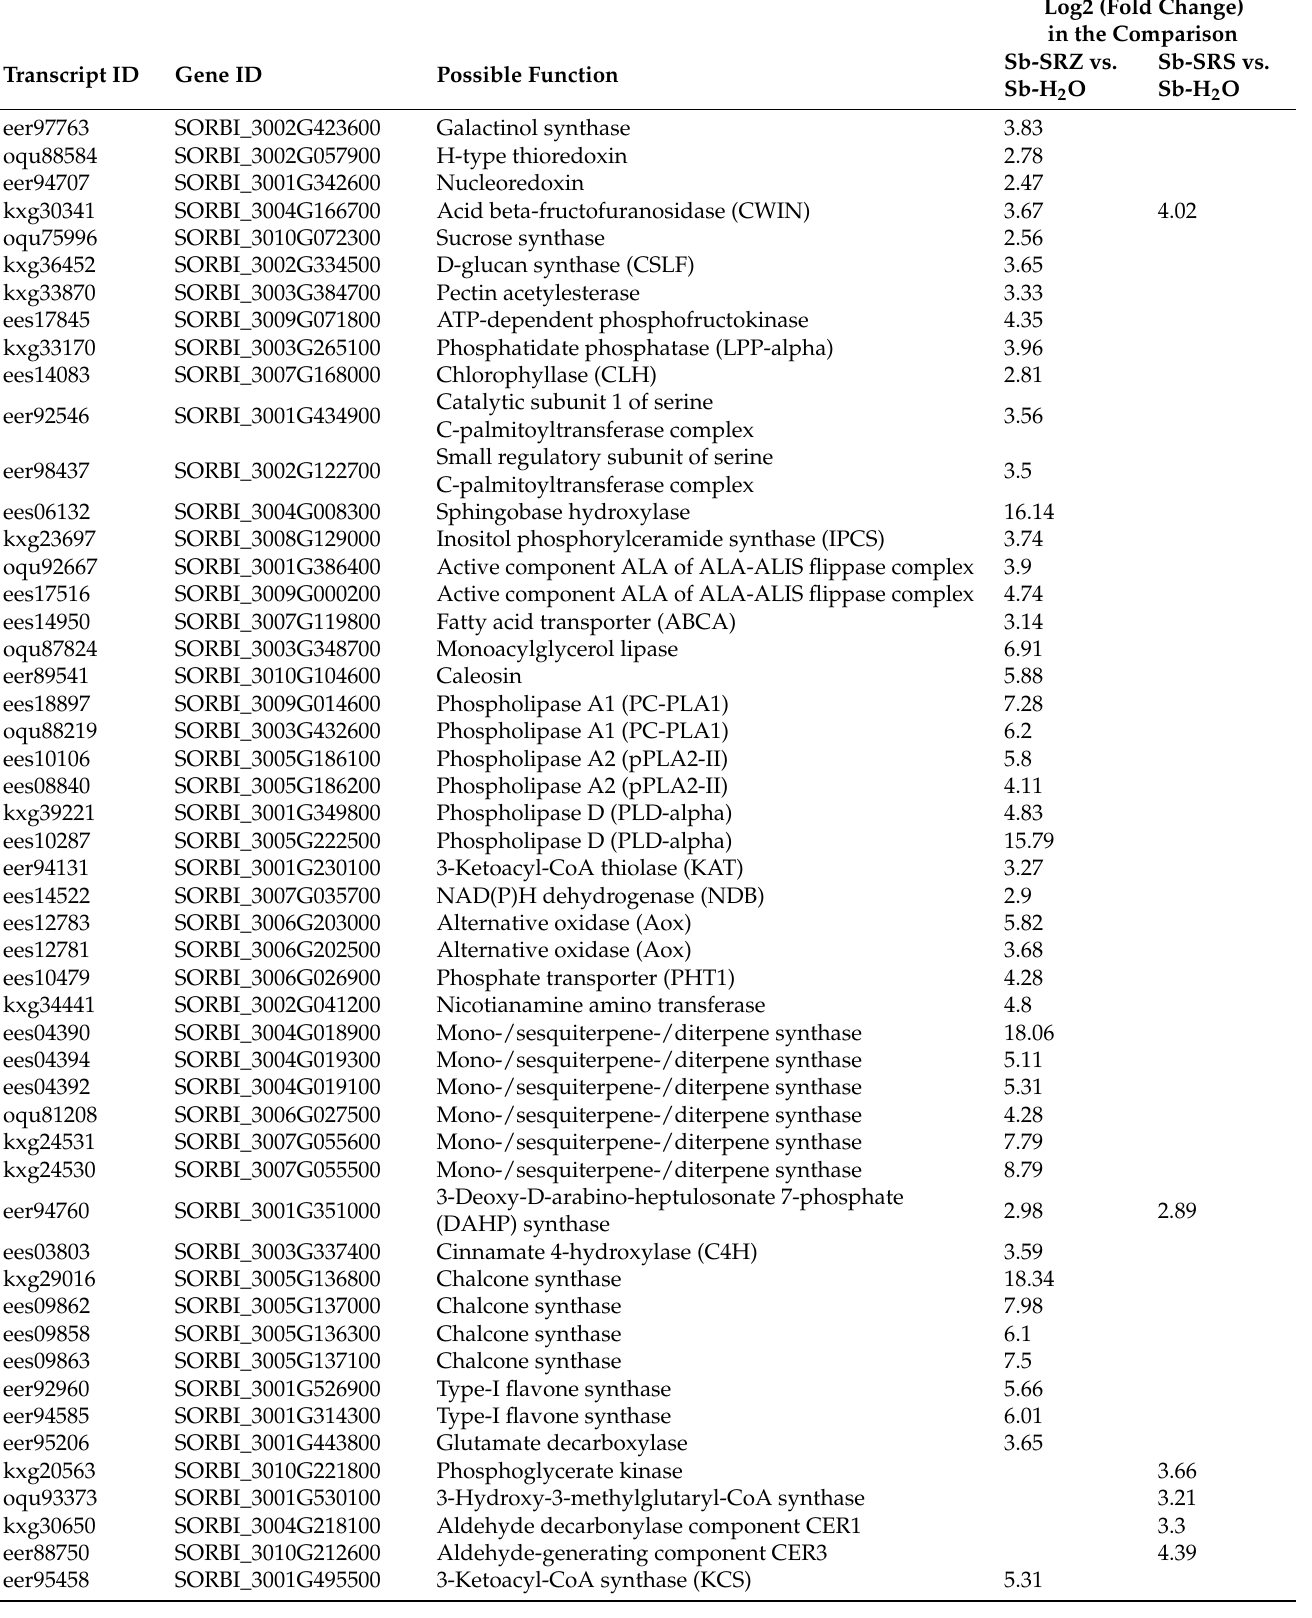
Table 2. Metabolic plant genes depicted in Figure 6 as significantly upregulated in either SRS- or SRZ-inoculated sorghum.